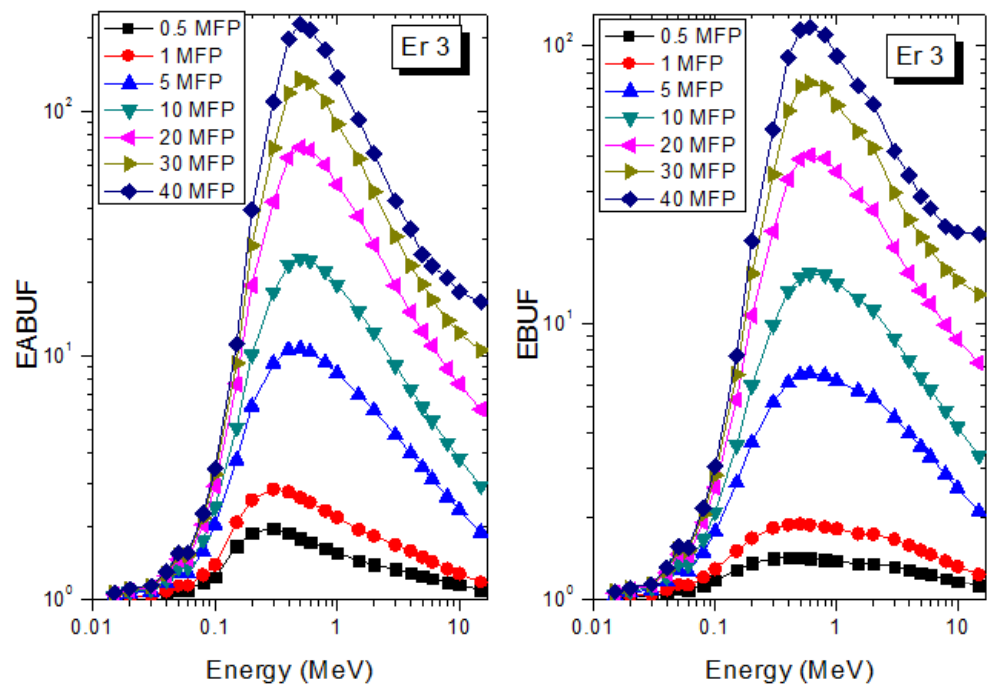
Figure 3. EABUF and EBUF variation with gamma-ray photon energy for Er3.